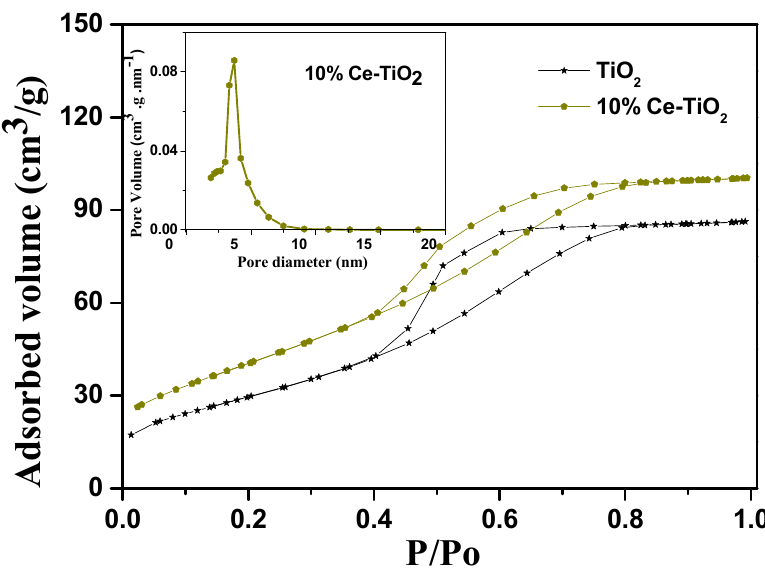
Figure 4. Sorption–desorption curves for pristine TiO 2 and cerium-modified TiO 2 films and pore size distribution (inset) of 10% cerium-modified TiO 2 films (adapted from [55] with copyright permission from Elsevier).